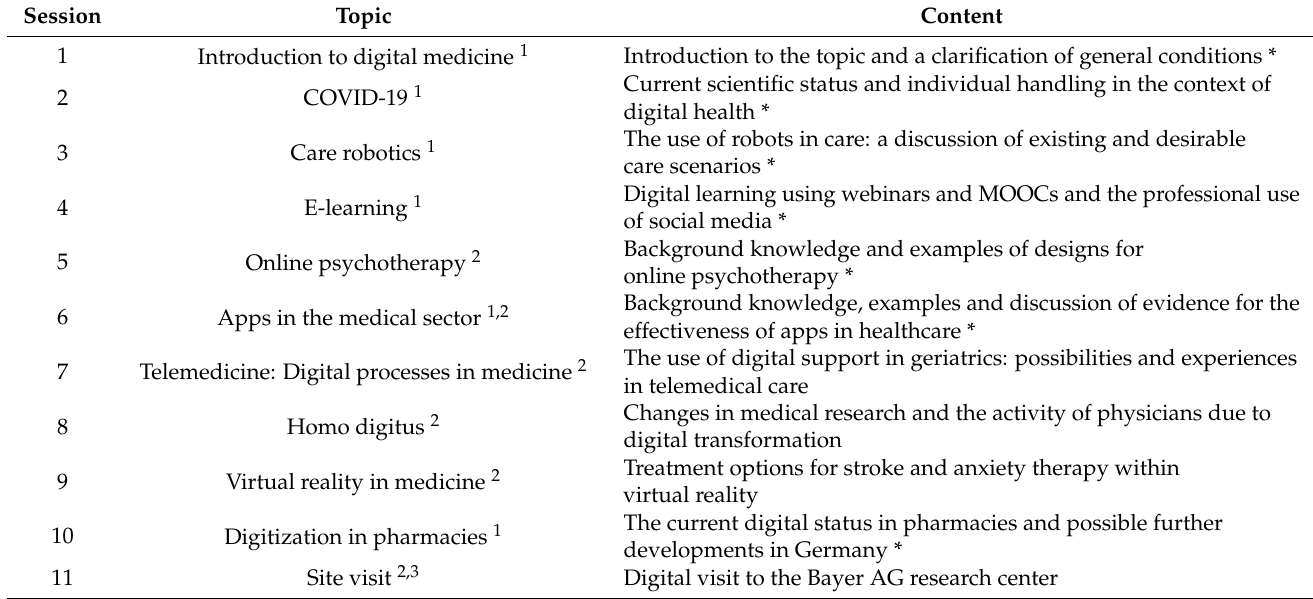
Table 1. An overview of the “Digital Medicine—How will data change the way we treat” program in